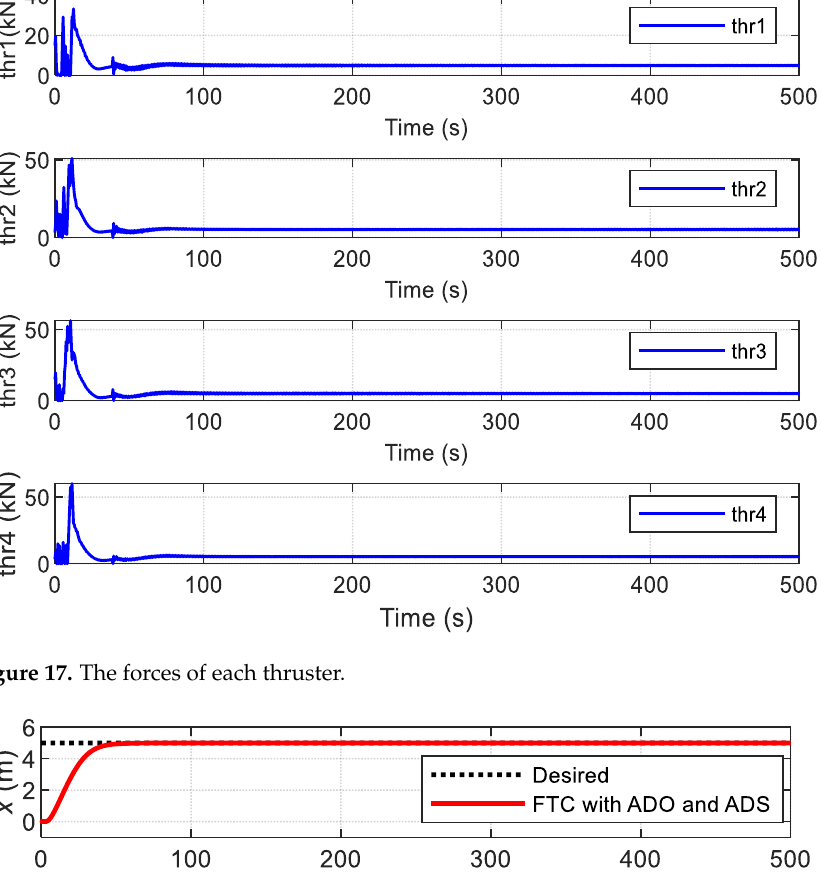
Figure 16. Control inputs